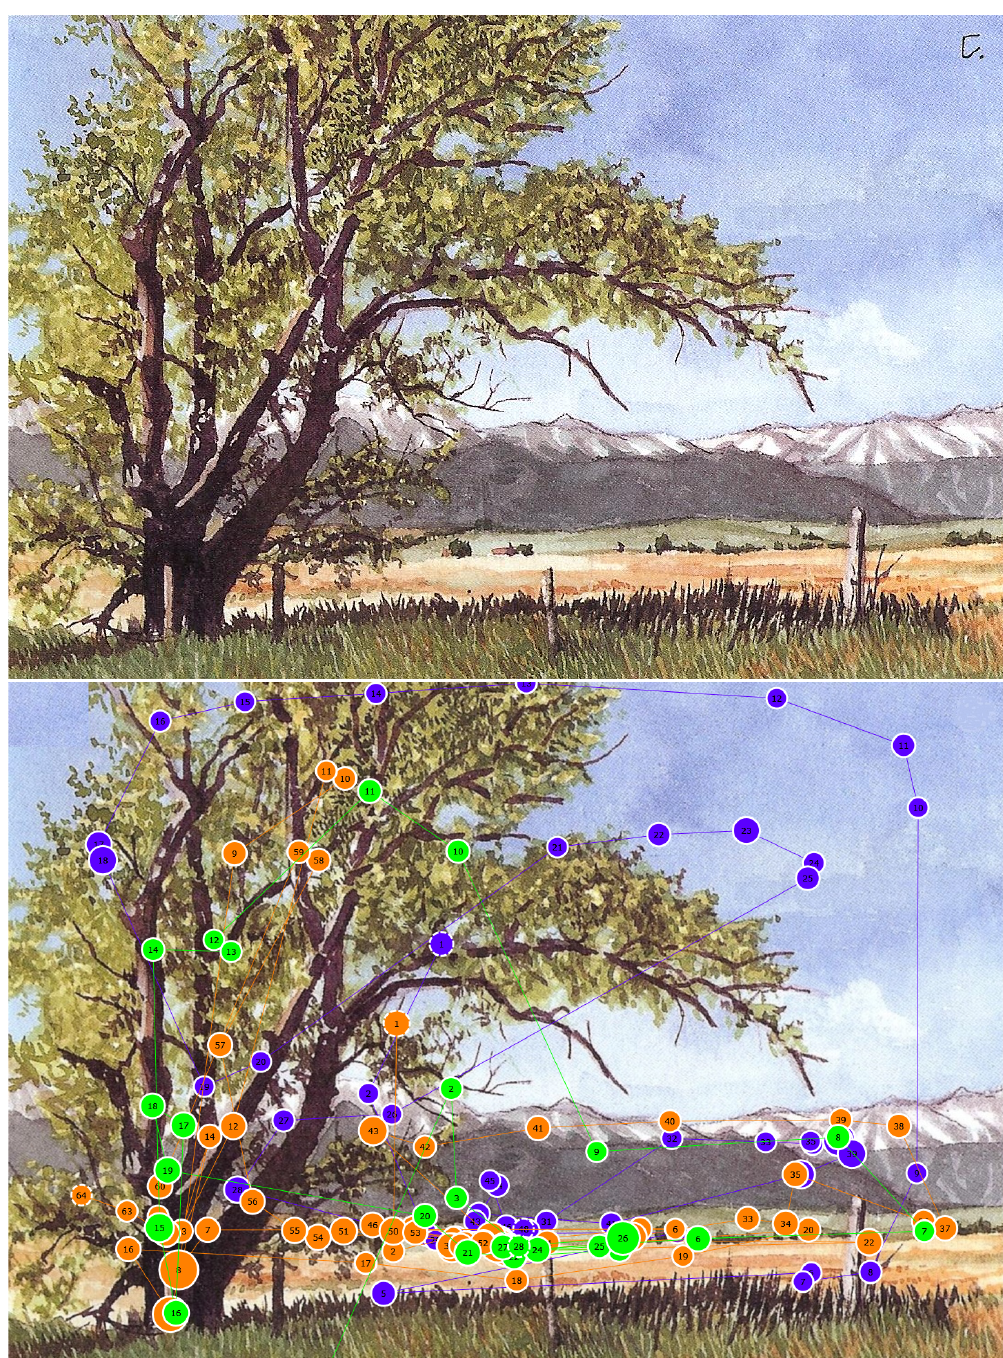
Figure 3. Gaze plots over Painting 2, Trees (Source: Nice,